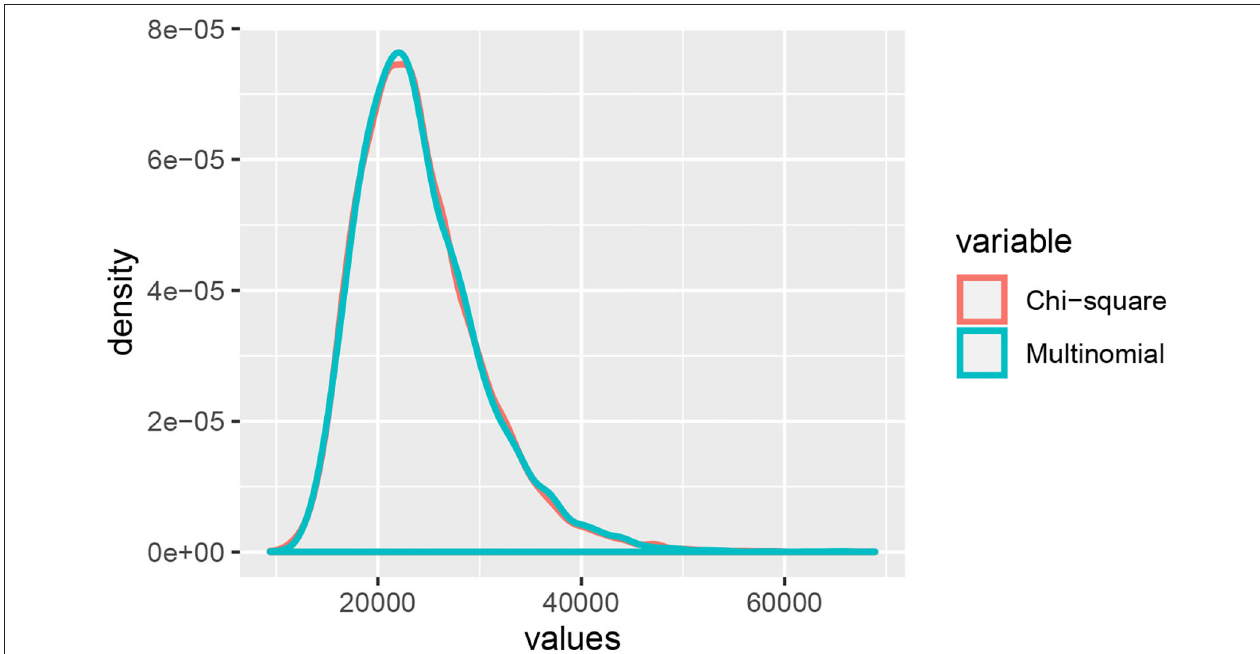
FIGURE 2 | A comparison of samples from Y ( n , p ) and the linear combination of chi-squared random variables with a distribution that approximates that of Y ( n , p ) .